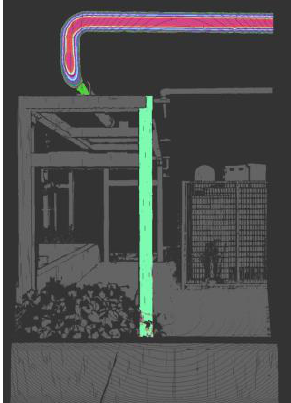
Figure 5. Example of sub-clustering by incident angle.